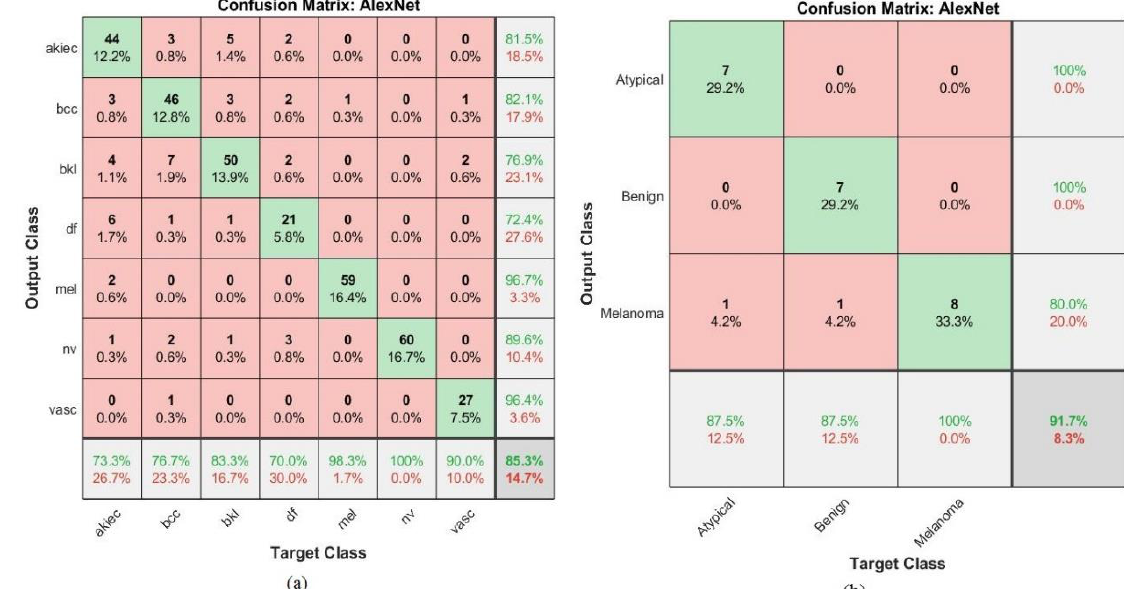
Figure 20. The ROC values reached by the ResNet-50 model considering the different datasets used. ( a ) The ISIC 2018 dataset. ( b ) The PH2 dataset.